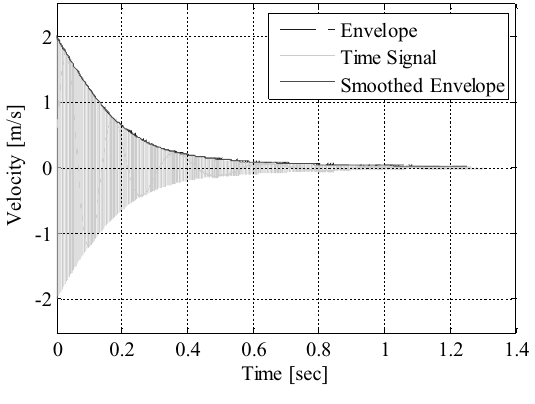
Fig. 13. Free decay of a bare